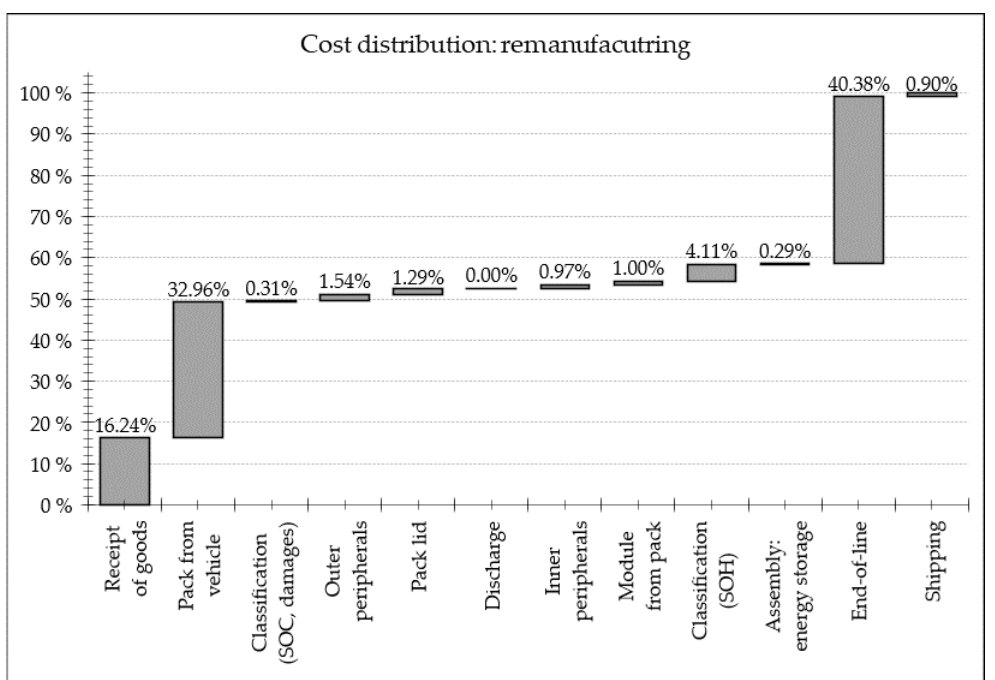
Figure 6. Cost distribution for the reuse scenario under standard cost assumptions.